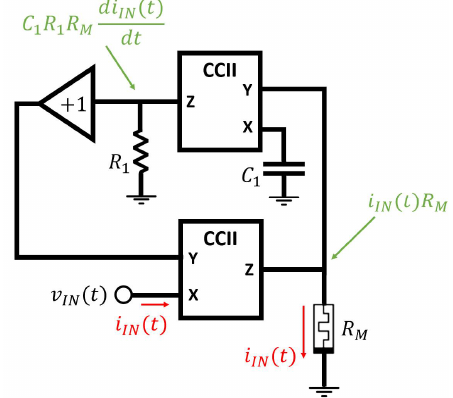
Figure 12. Meminductor emulator circuit proposed by Sah et al. [51].